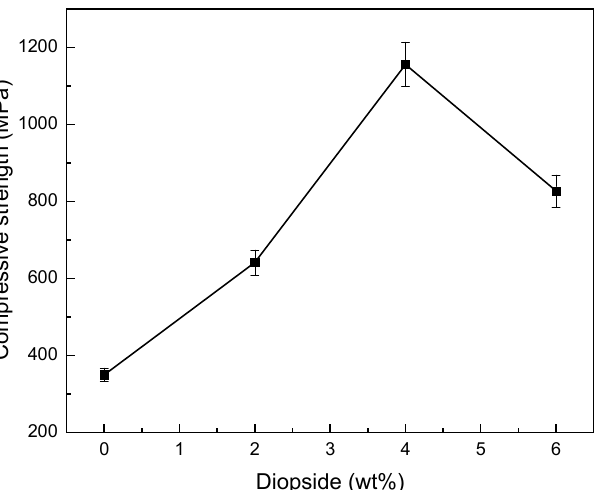
Figure 6. Amount of fluoride released from glass ionomer cement (GIC) and glass ionomer cement (GIC)-4 diopside (DIO) nanocomposite for 14 days immersion in artificial saliva.